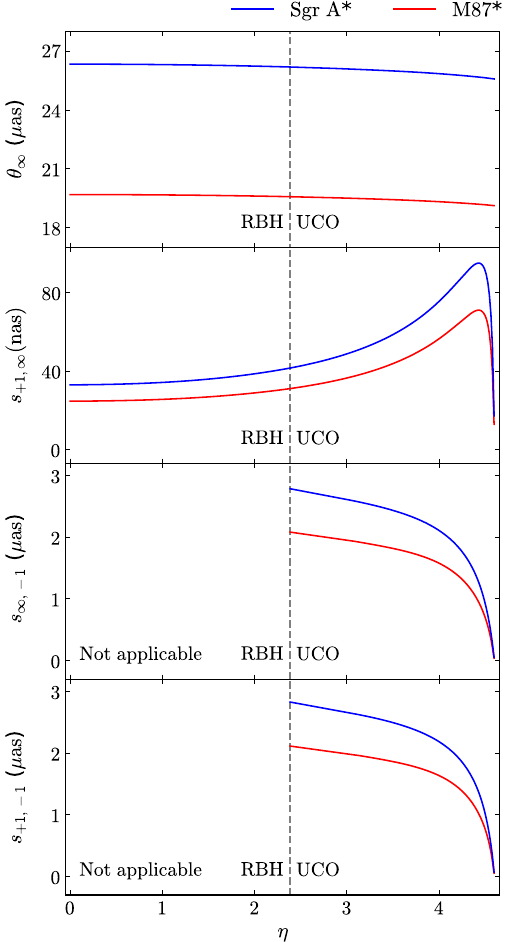
Fig. 4 The apparent radius of the photon sphere θ ∞ and the angular separations between relativistic images s + 1 , ∞ , s ∞ , − 1 and s + 1 , − 1 are shown with respect to η for an Einstein–Lovelock regular black hole (if applicable) and for an Einstein–Lovelock ultracompact object in the cases of Sgr A* (blue) and M87* (red)